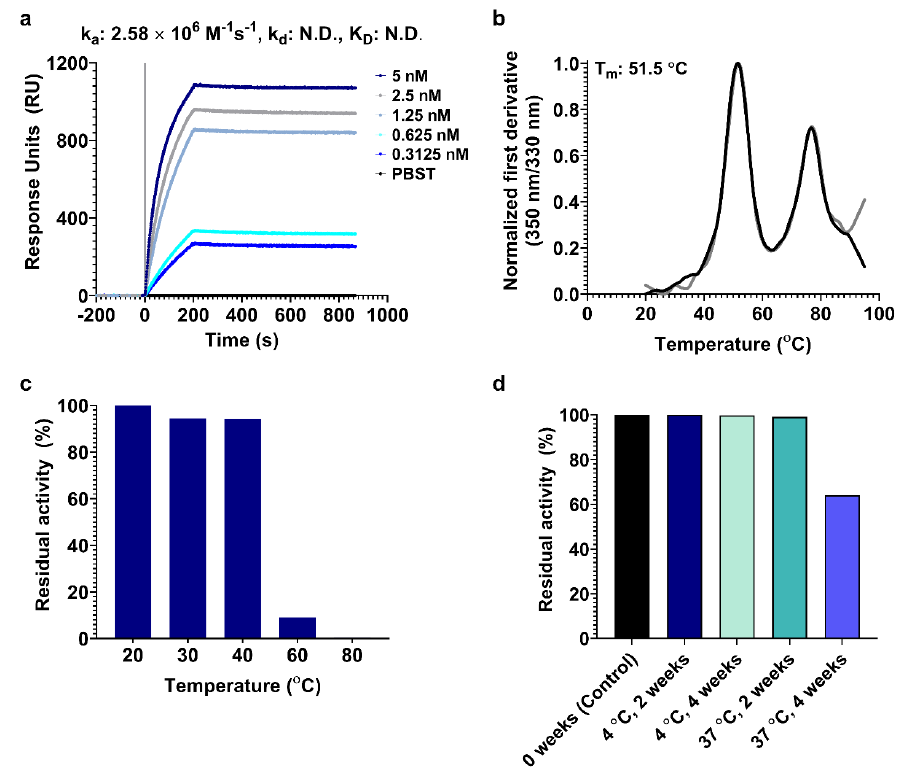
Figure 2. Antigenic characterization of Encapsulin-mRBD nanoparticles . ( a ), SPR-binding kinetics of encapsulin – mRBD to human ACE-2 receptor Fc region (ACE2-hFc). Five concentrations of